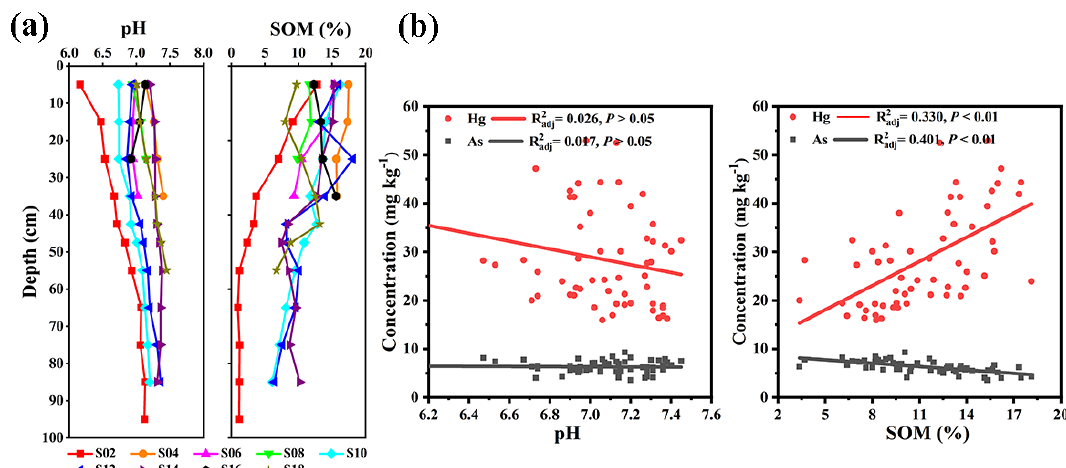
Figure 4. Vertical distribution of soil pH and SOM ( a ) and the correlation between Hg and As concentrations, and pH and SOM content, in the soil profile ( b ).